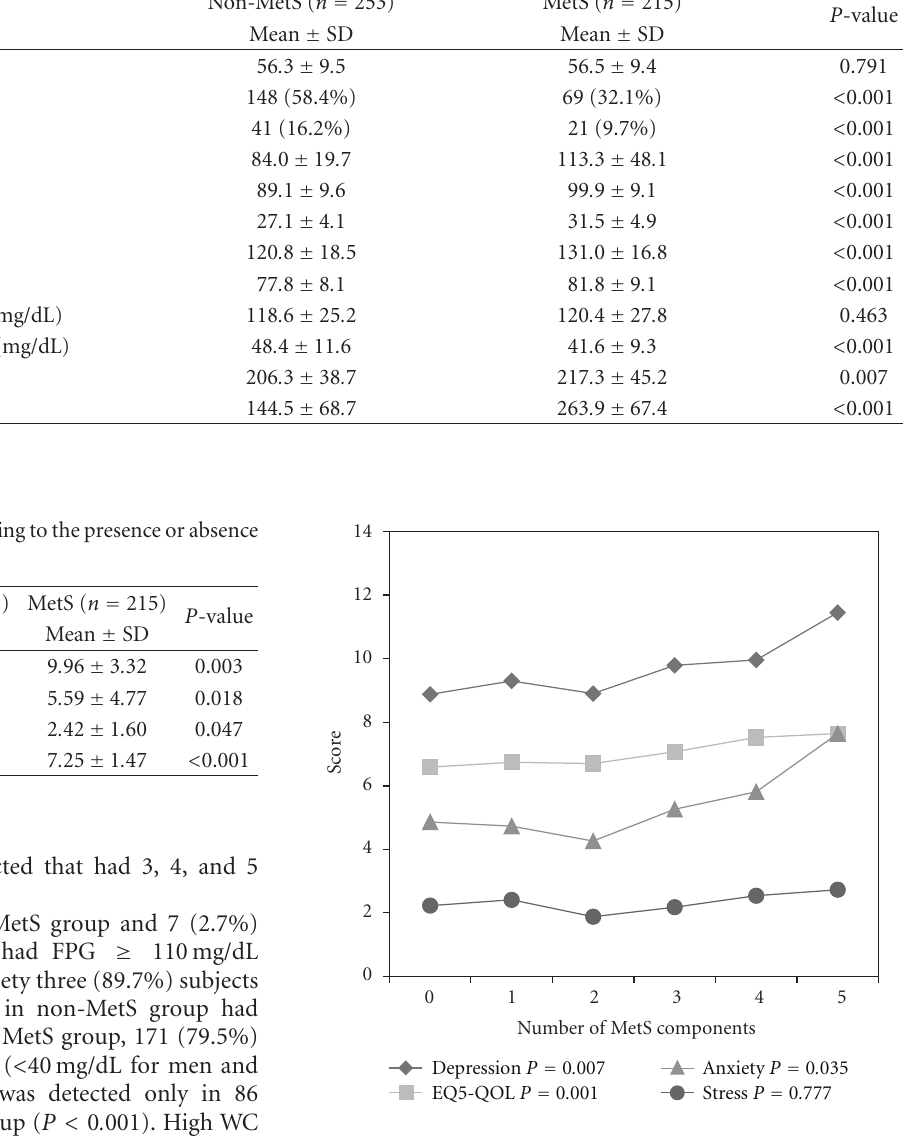
Figure 1: Psychological variable according to the number of metabolic syndrome